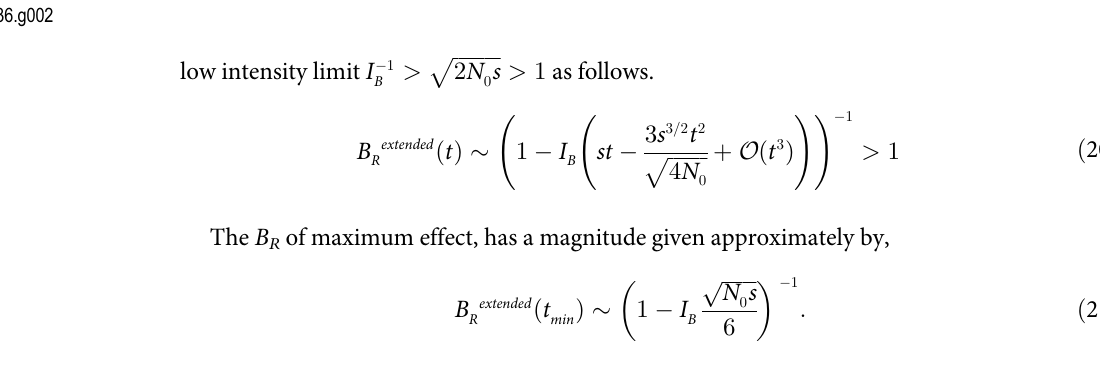
Fig 2. Time dependence of the B R statistic after re-expansion. The time dependence of B R ( t ) after a population bottleneck is shown for for alleles under recessive selection ( h = 0) for various selection strengths. Peak B R values vary in both magnitude and time as a function of s . The founded population was simulated with 2 N 0 = 20000, 2 N B = 2000, and T B = 200 and plotted for 5000 generations after